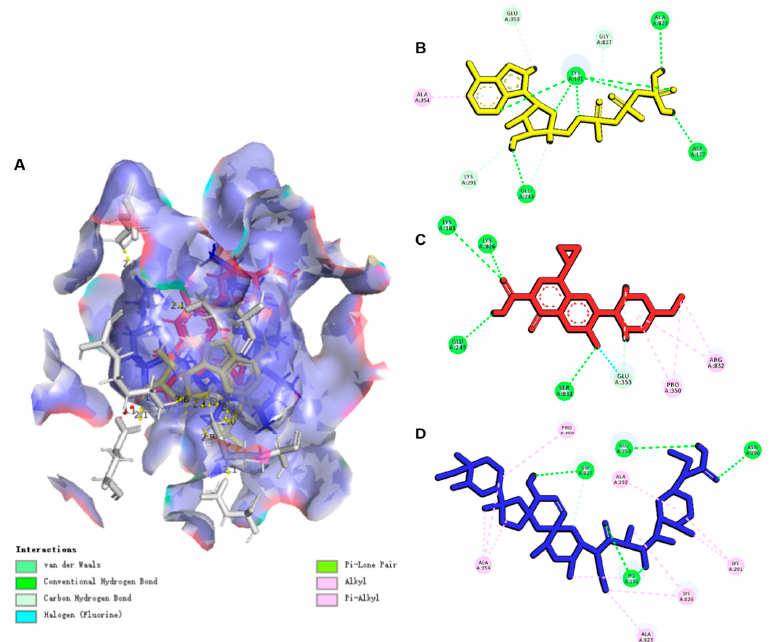
Figure 9. Molecule docking simulations of compounds with P-gp (PDB ID: 6C0V). ( A ): ENR (Red), SAL (Blue) and ATP (Yellow) in the active area of P-gp (PDB ID: 6C0V). ( B – D ) are 2D maps of the interaction of ENR, SAL and ATP with P-gp, respectively. The green dashed lines indicate hydrogen bonding forces between compounds and amino acid residues. Antibiotics 2023 , 12 , x FOR PEER REVIEW